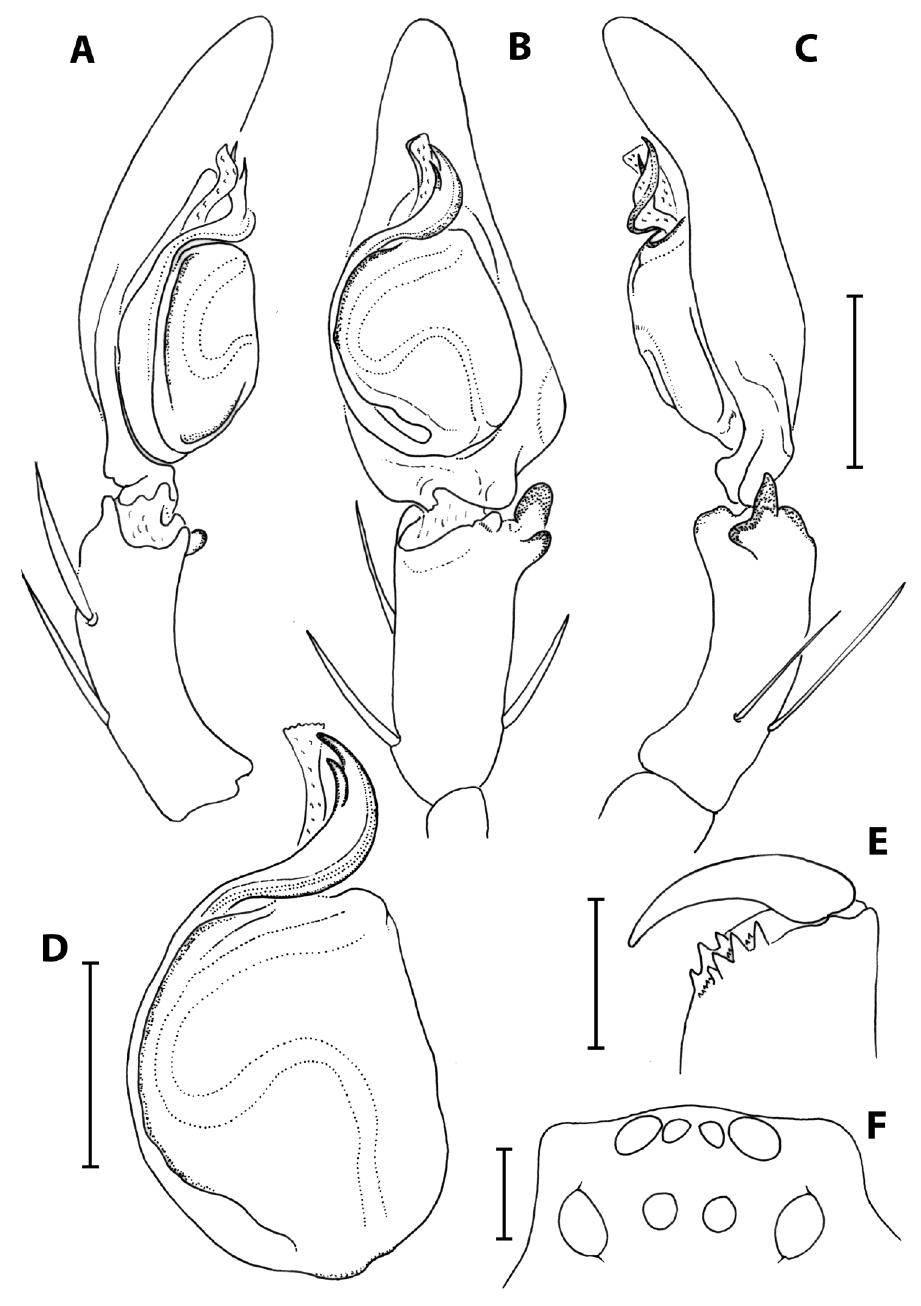
Figure 4. Spariolenus mansourii sp. n., male holotype, Kohgiluyeh and Bouyer-Ahmad Province, Nezel Cave entrance, Iran (SMF). A–C left palp ( A prolateral B ventral C retrolateral) D bulbus, ventral E chelicerae, ventral F eye arrangement, dorsal. Scale bars: 1